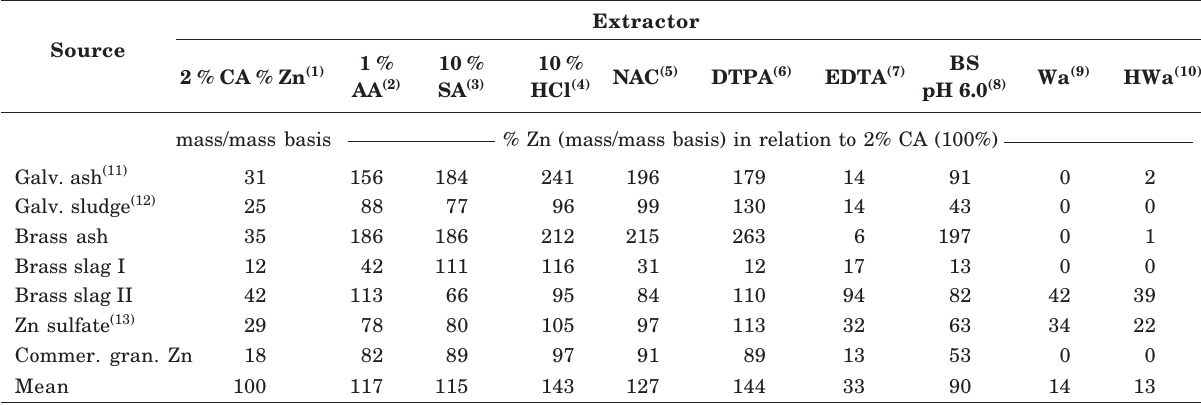
(1) 2 % CA: 2 % citric acid. (2) 1 % AA: 1 % (v/v) acetic acid. (3) 10 % SA: 10 % (v/v) sulfuric acid. (4) 10 % (v/v) HCl. (5) NAC: neutral ammonium citrate+water at 1:1 ratio. (6) 50 mmol L -1 DTPA. (7) 5 mmol L -1 EDTA. (8) BS 6.0: buffer solution pH 6.0. (9) Wa: water. (10) HWa: hot water. (11) Galvanizing ash. (12) Galvanic sludge. (13) Sample dried in a desiccator. Means followed by the same letter in a row did not differ by the Scott-Knott test at 95 % probability. Table 6. Percentage of Zn recovered from the sources compared to the official MAPA extractor 2 % citric acid (2 %